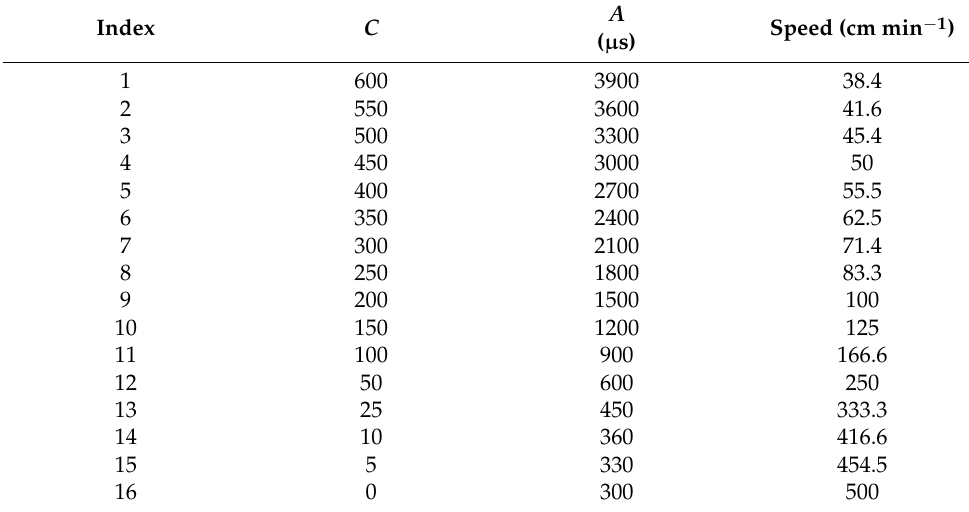
Table 5. Values of the variables A and C of Equation (1), in acceleration case, to gradually achieve the speed of 500 cm min − 1